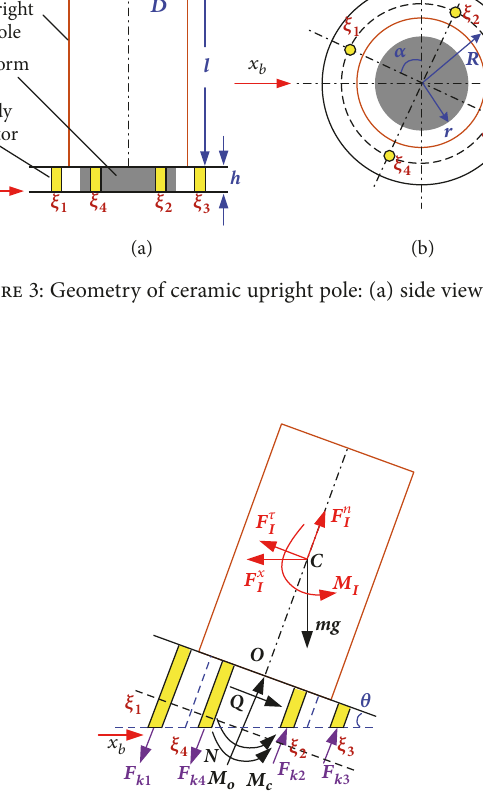
Figure 4: Dynamic equilibrium of ceramic upright pole under base